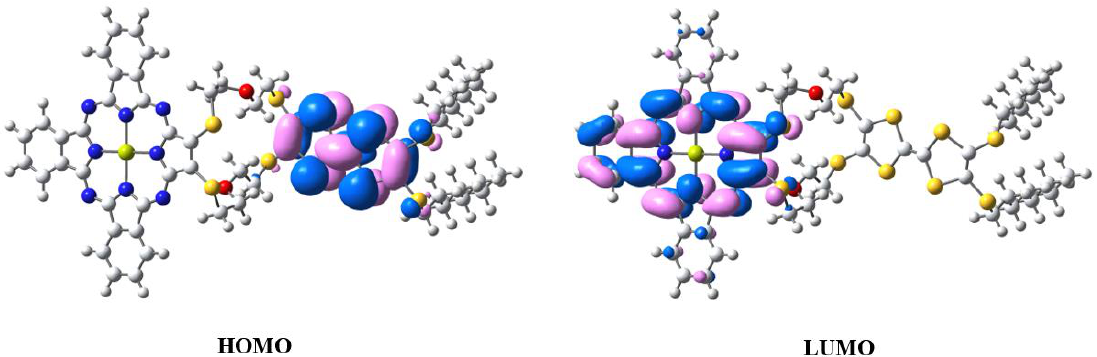
Figure 1. Diagram of the HOMO and LUMO of compound 1 .